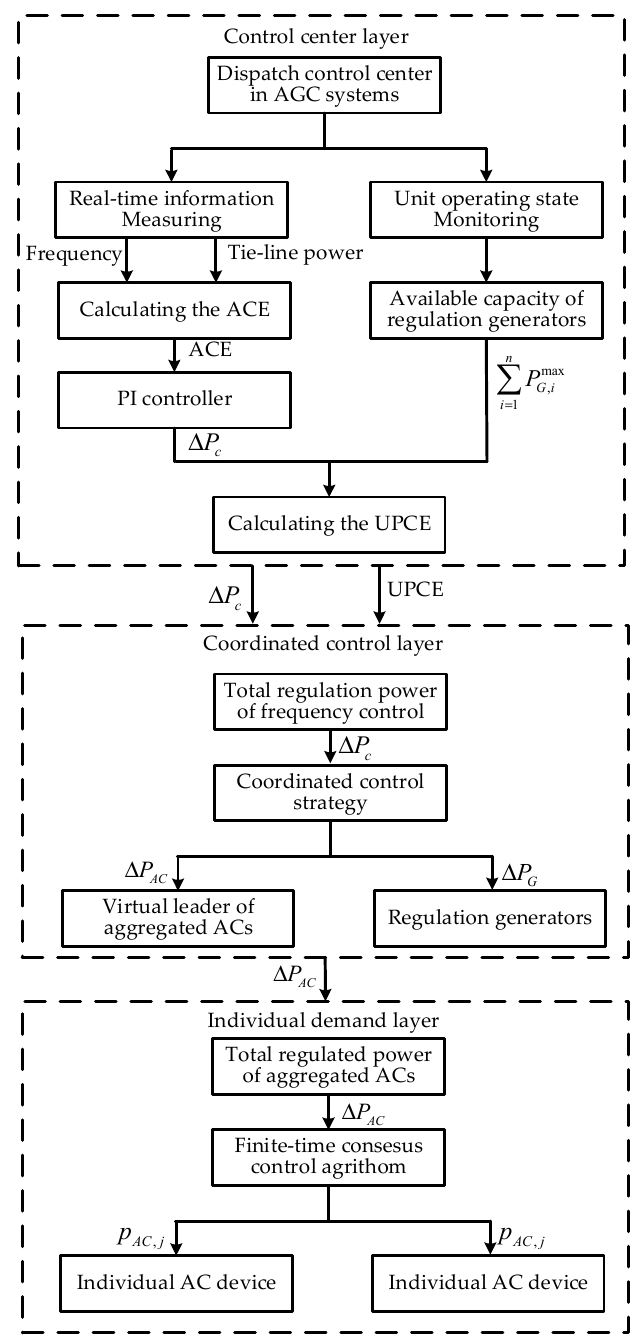
Figure 1. Hierarchical frequency control scheme. AGC—automatic generation control; ACE—area control error; PI—proportional integral; UPCE—an adjustable control error based on unit capacity; AC—air conditioning.